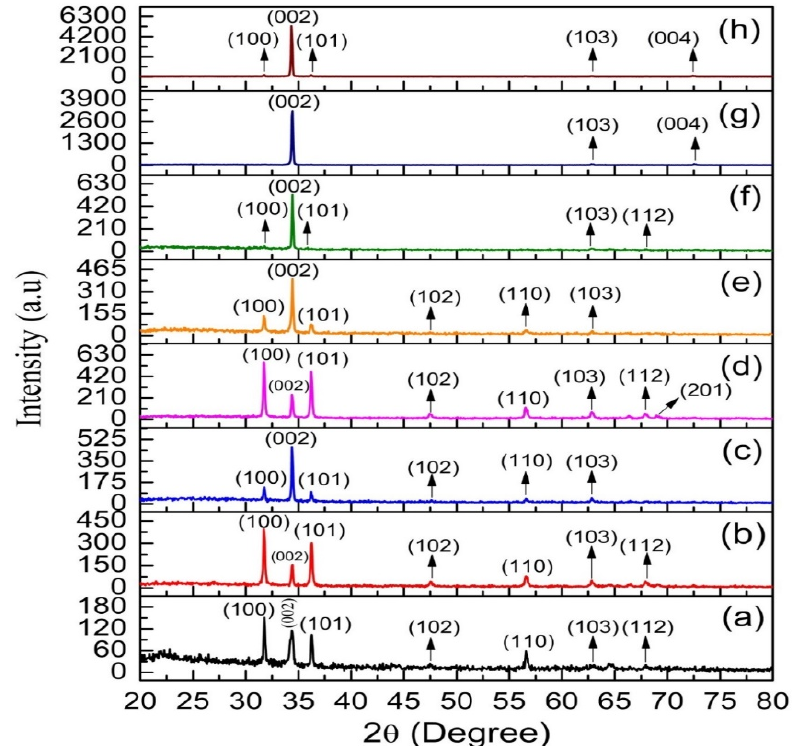
Figure 6. X-ray diffraction (XRD) patterns of ZnO nanorods for different precursor concentrations in the absence of air bubbles: ( a ) 0.01 M, ( b ) 0.025 M, ( c ) 0.05 M and ( d ) 0.075 M and the presence of air bubbles: ( e ) 0.01 M, ( f ) 0.025 M, ( g ) 0.05 M and ( h ) 0.075 M.